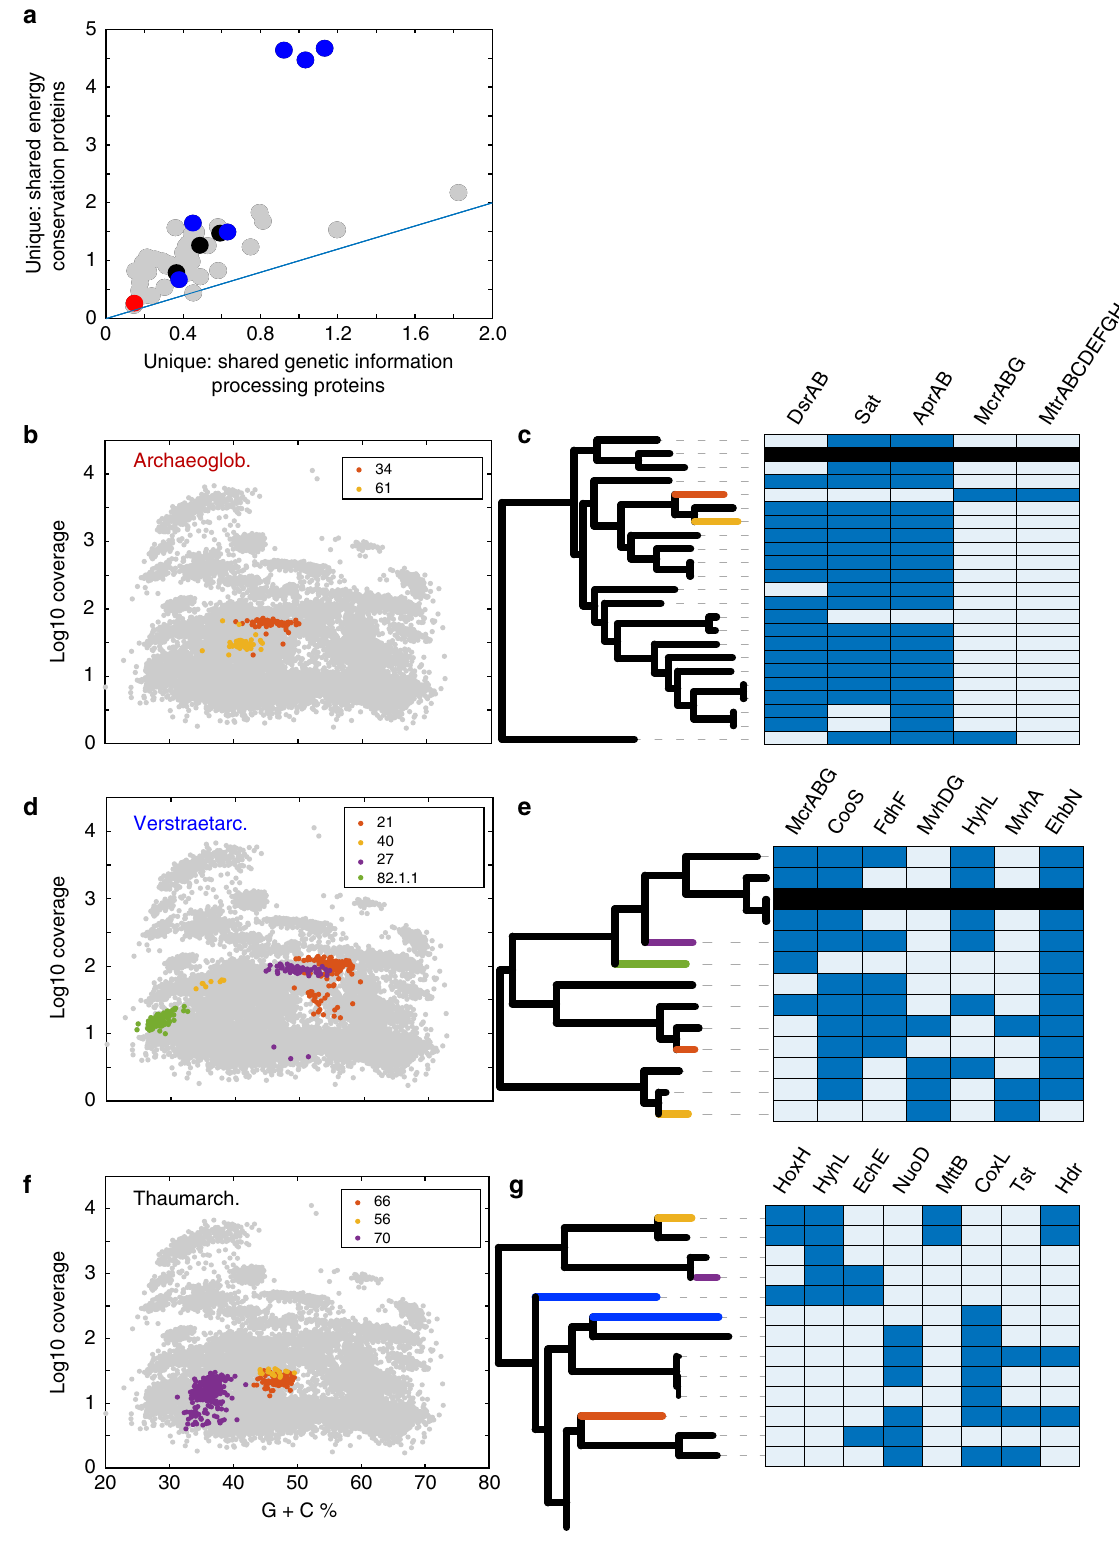
Fig. 7g; Supplementary Data 8) 56 . Conversely, genes coding for carbon monoxide dehydrogenase (CoxL) and thiosulfate sulfur- transferase (Tst) suggests the ability to use CO and S 2 O 3 − as electron donors, respectively, in the population represented by the SJ3.Bin66 MAG (and other later-diverging thaumarchaeotes). Genes encoding these proteins were absent in the deeper-